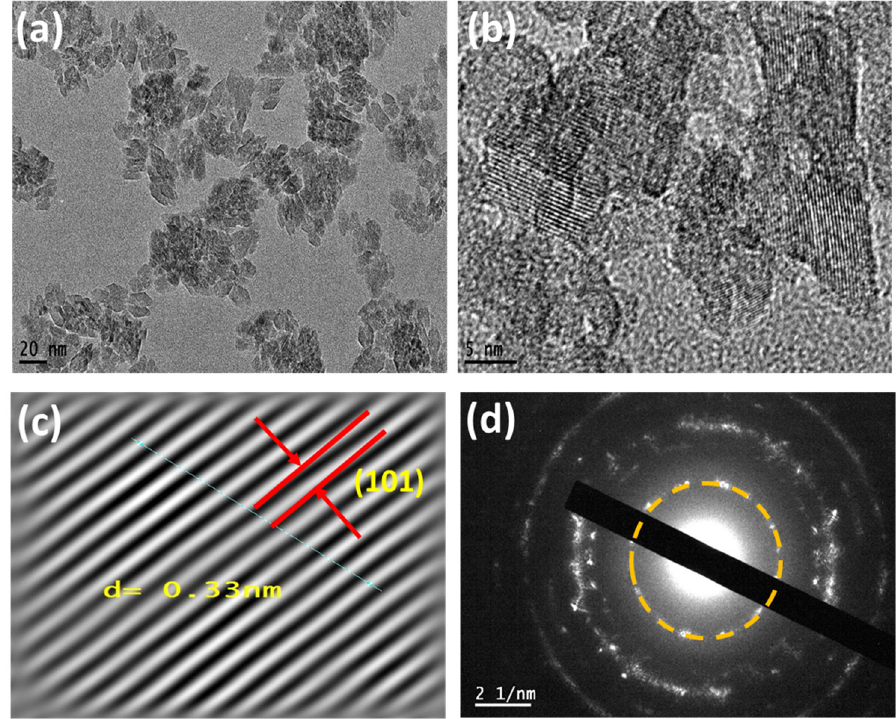
Figure 2. ( a , b ) TEM images, ( c ) HRTEM image, and ( d ) SAED pattern of 5 nm TiO 2 nanoparticles. XRD patterns were measured to show the structure and phase composition of Nb(x)/TiO